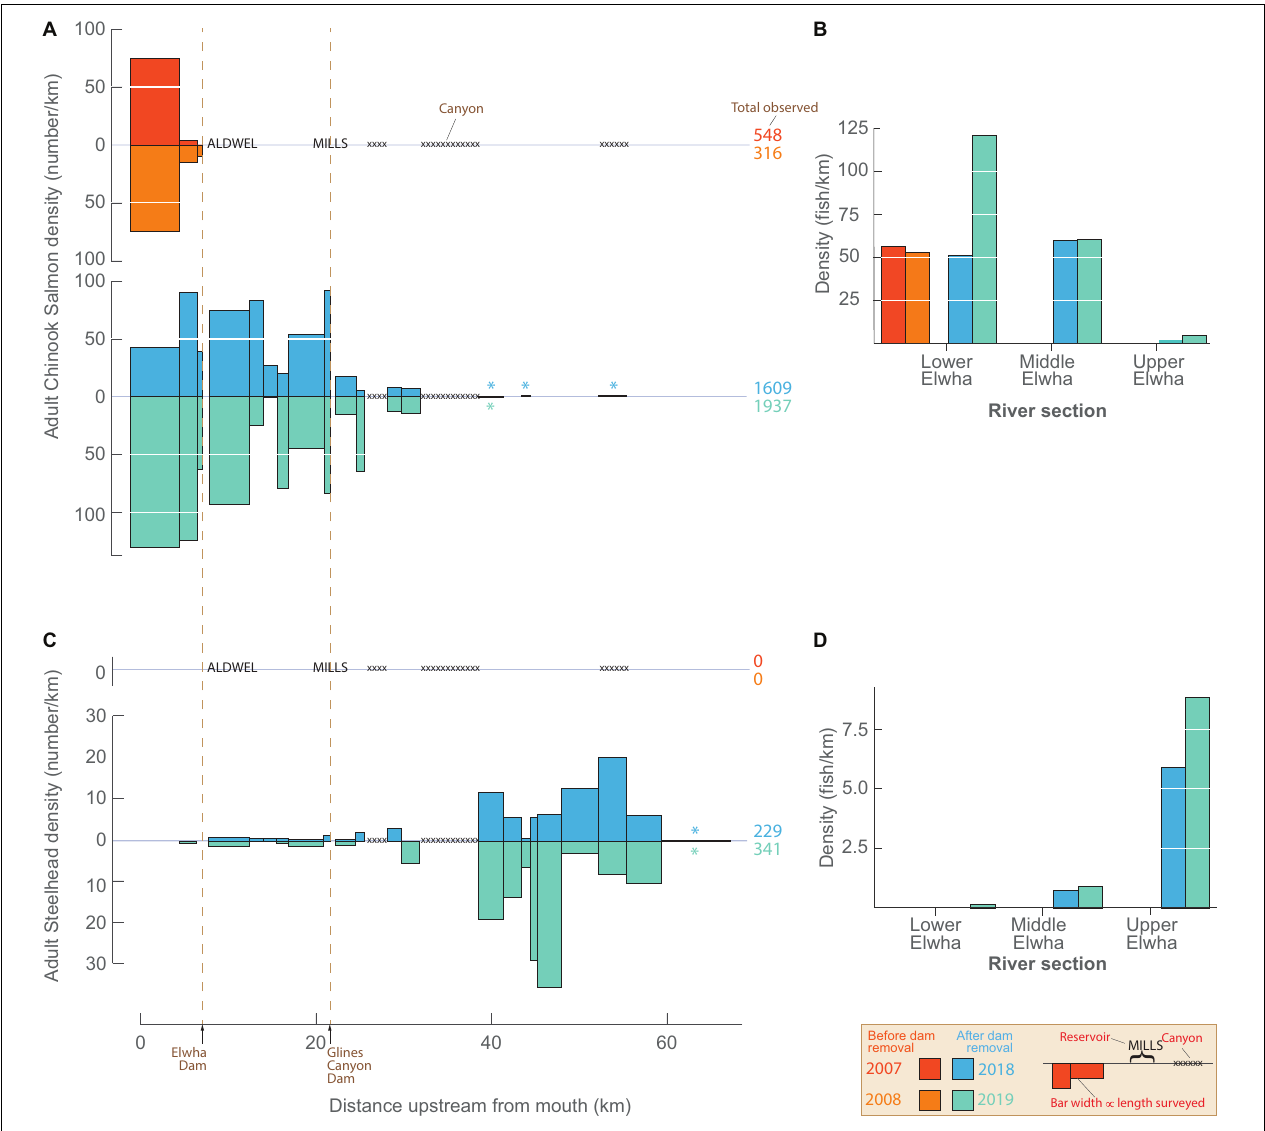
FIGURE 4 | Snorkeling survey results showing the density (number/km surveyed) of Chinook Salmon and Summer Steelhead observed during 4 riverscape surveys. Densities are shown for reaches (A,C) and river sections (B,D) , with demarcations of reaches and sections shown in Figure 1 . The 2007 and 2008 surveys (warm colors) occurred prior to dam removal and the 2018 and 2019 surveys (cool colors) occurred after most dam removal effects (e.g., sediment release, turbidity, channel geomorphology; Ritchie et al., 2018) had dissipated. The start and end locations of each river section were standardized across surveys (see section “Common reaches across the four survey years”) and the width of each bar is proportional to the length of the survey measured in the field. Unsurveyed reservoir and canyon sections indicated by labels and cross-hatch, respectively. Asterisks above and below bars indicate very low densities ( > 0) that are not clearly visible due to the scale of the